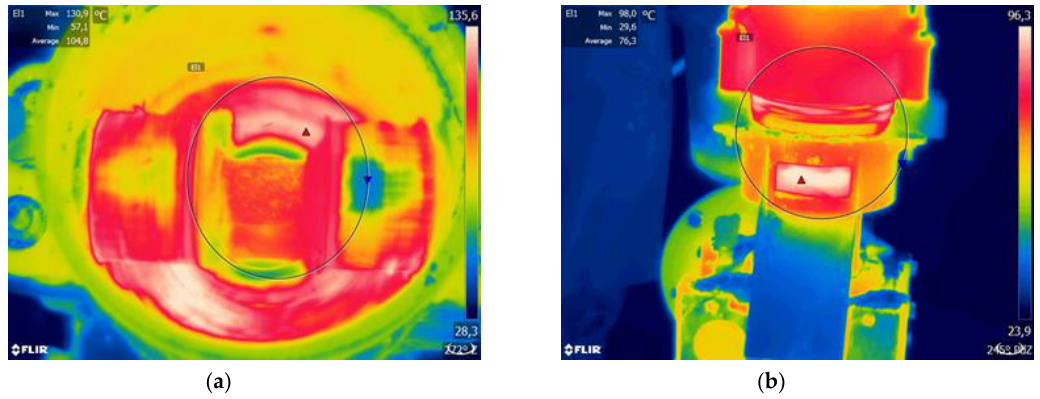
Figure 16. Thermographs from IR camera while using the modified RDF die: ( a ) view of die and rollers, and ( b ) view of pellet output.